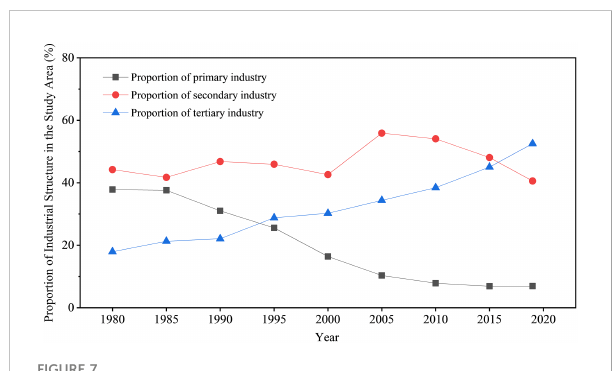
FIGURE 7 Industrial structure variations in the Laizhou Bay Area from 1980 to